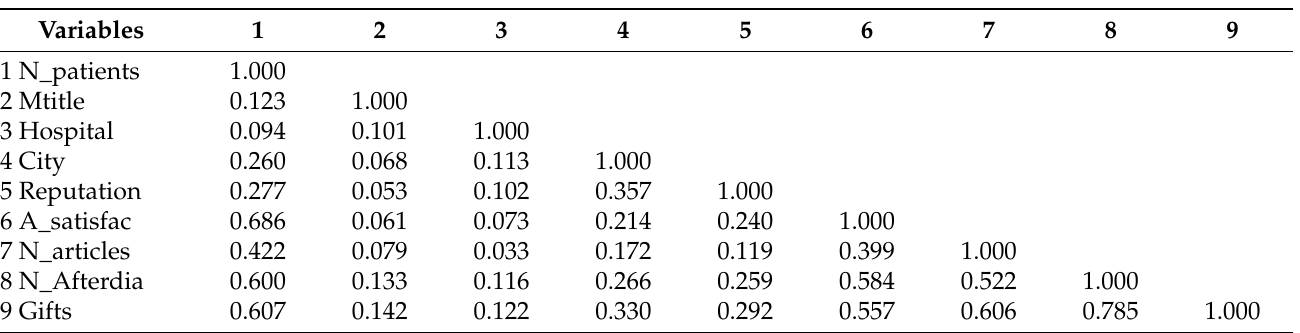
Table 2. Correlation analysis